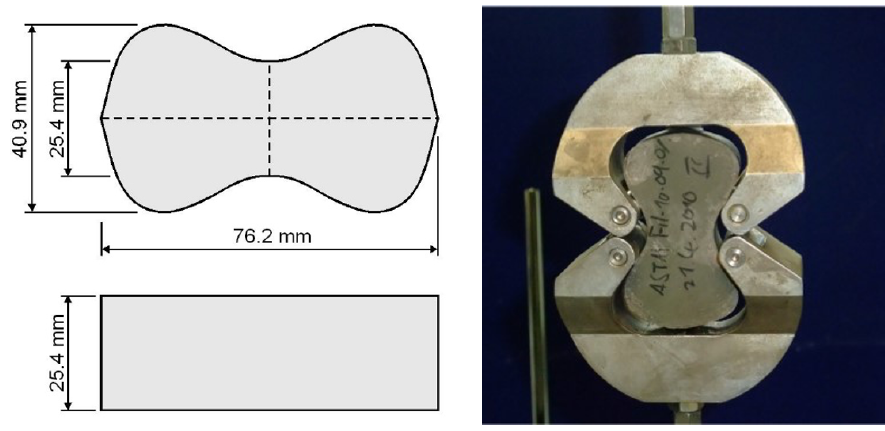
Table 2. Strength development of cements and fly ash.